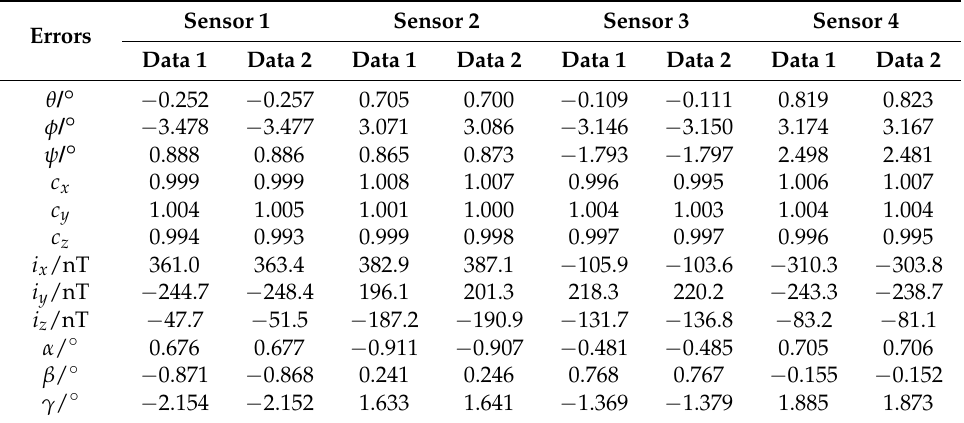
Table 6. Estimation error parameters of different measurement data after the calibration